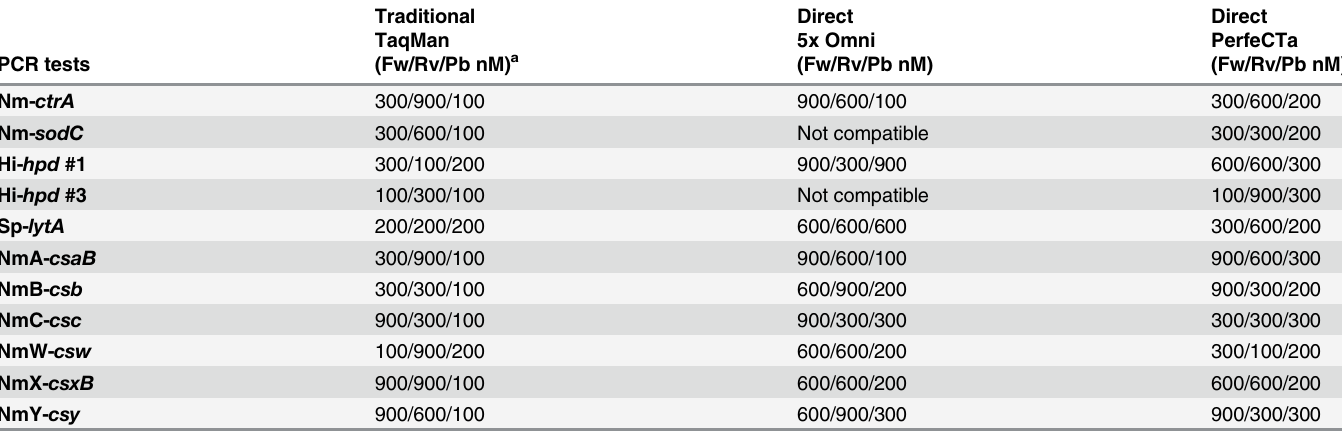
Table 1. Final concentrations of primers and probes for the real-time PCR tests for detection of Neisseria meningitidis and its 6 serogroups, Hae- mophilus influenzae , and Streptococcus pneumoniae using traditional and direct methods a